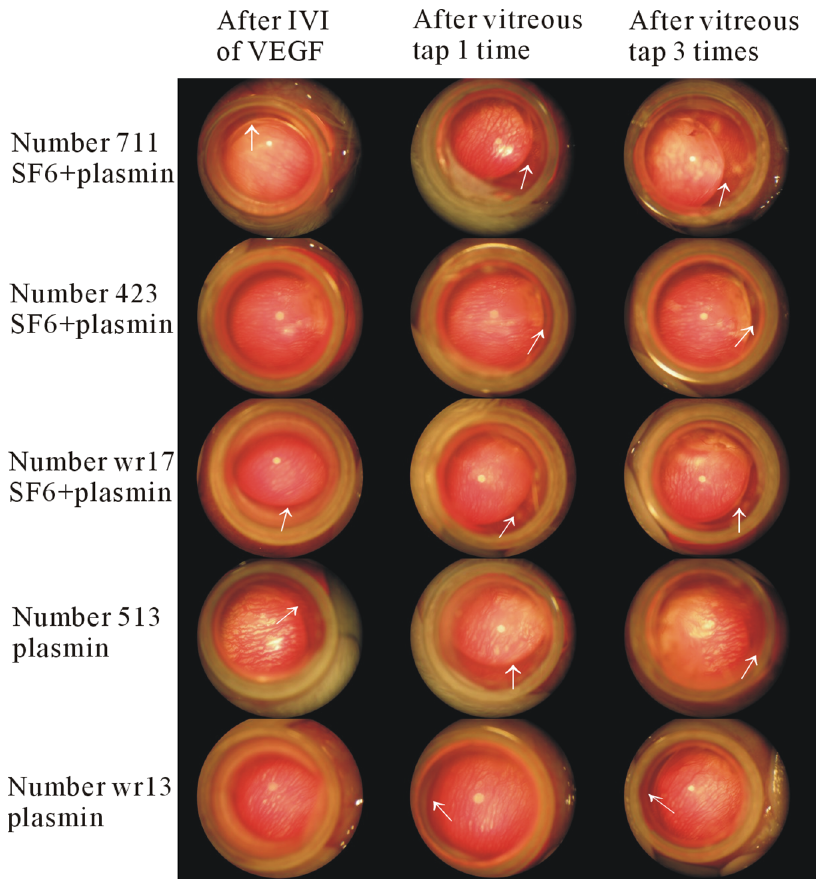
Figure 2. Lens subluxation following plasmin treatment. Representative figures of lens subluxation after intravitreal injections of plasmin and SF 6 , or plasmin alone, with a subsequent high intraocular level of vascular endothelial growth factor (VEGF), and vitreous tap. After intravitreal injections of plasmin with/without SF 6 , VEGF, and vitreous tap, lens subluxation was noted in the eyes treated with plasmin and SF 6 (plasmin + SF 6 group) or plasmin alone (plasmin group) (white arrows). Lens subluxation was progressive in some cases (case number 711, wr17, and wr13) and stationary in others (case 423, and 513). IVI, intravitreal injection.